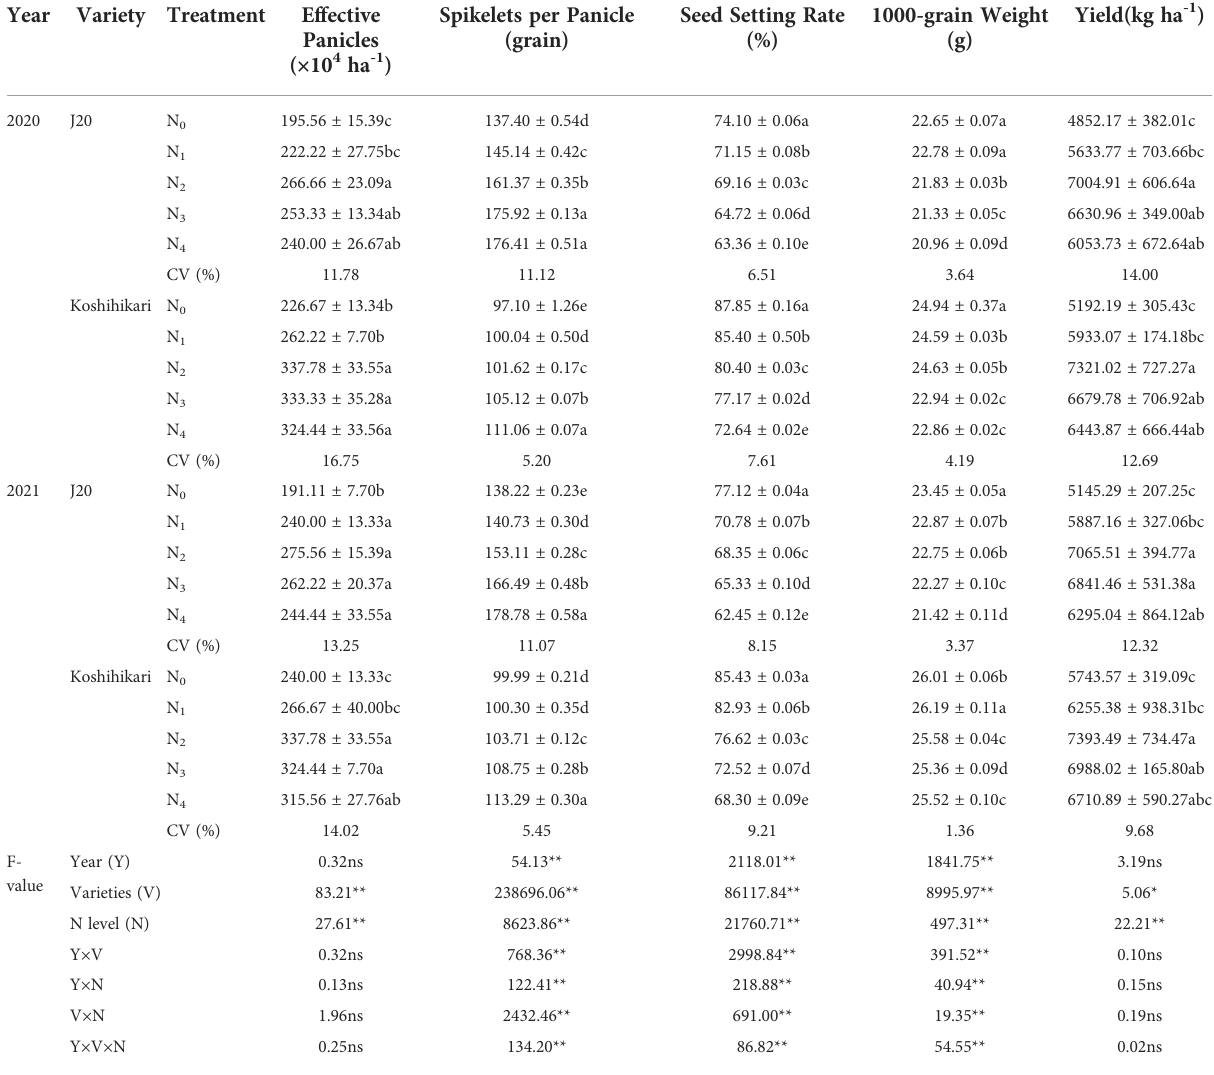
TABLE 2 Effects of N application rate on rice yield and yield